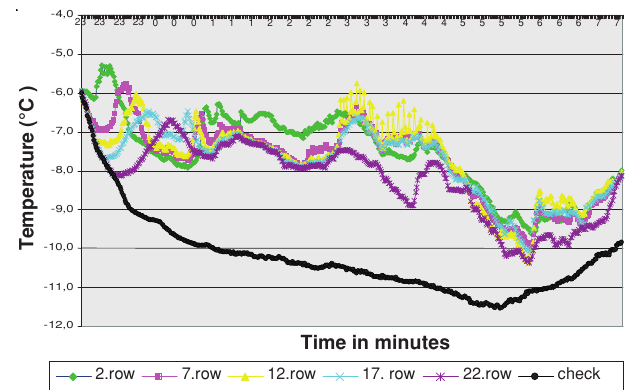
Figure 2. Temperatures measured in the plantation during the whole night at the different points of the rows of the area treated /Siófok, 2011. Febr. 23–24/